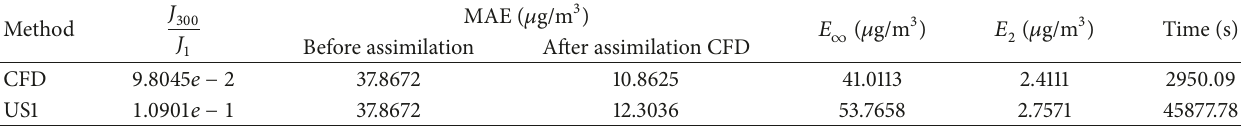
Table 5: 𝐽 300 /𝐽 1 , errors, and run time inverted by the adjoint assimilation method with different schemes.